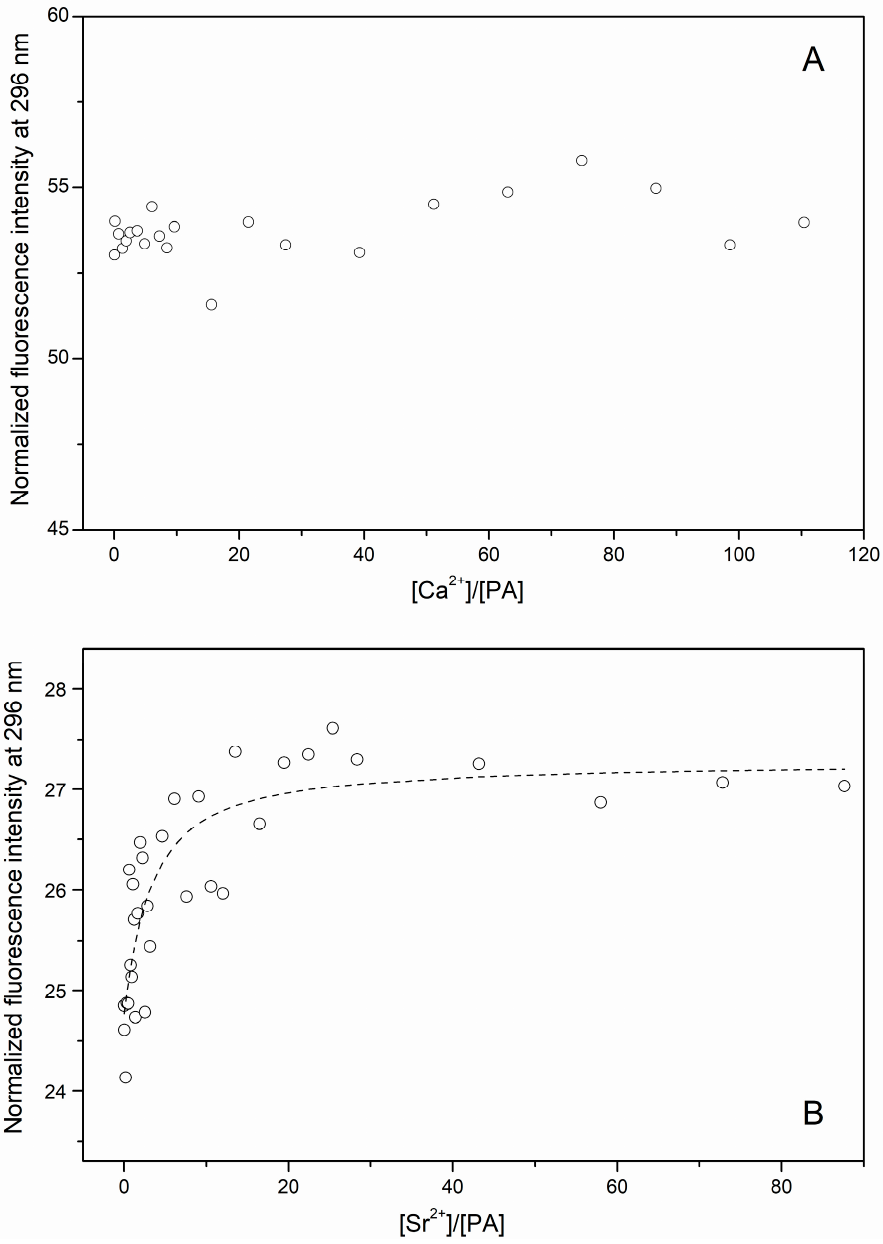
Figure 4. Spectrofluorimetric study of competition between Sr 2+ and Ca 2+ for rWT α -PA at 20 °C (10 mM HEPES-KOH, pH 8.1). Fluorescence was excited at 259 nm. ( A ) Titration of metal-depleted α -PA (12 µM) by Ca 2+ in the presence of 100 µM SrCl 2 . ( B ) Titration of α -PA (1 µM) by Sr 2+ in the presence of 100 µM CaCl 2 .